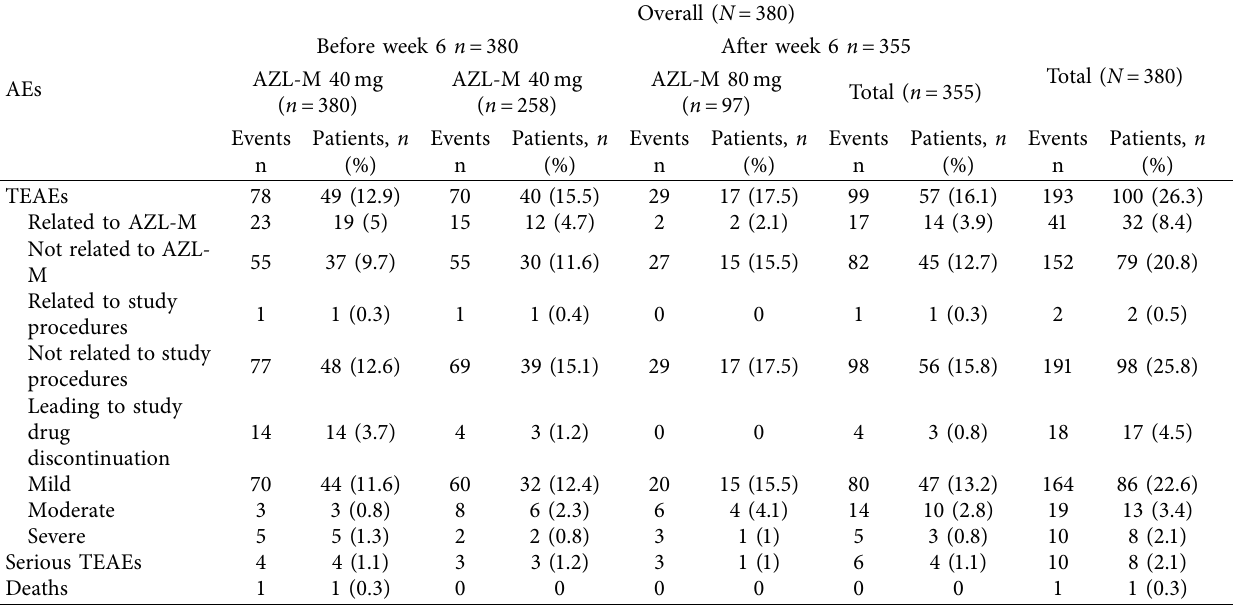
Table 4: Frequency of AEs :safety analysis set and overall